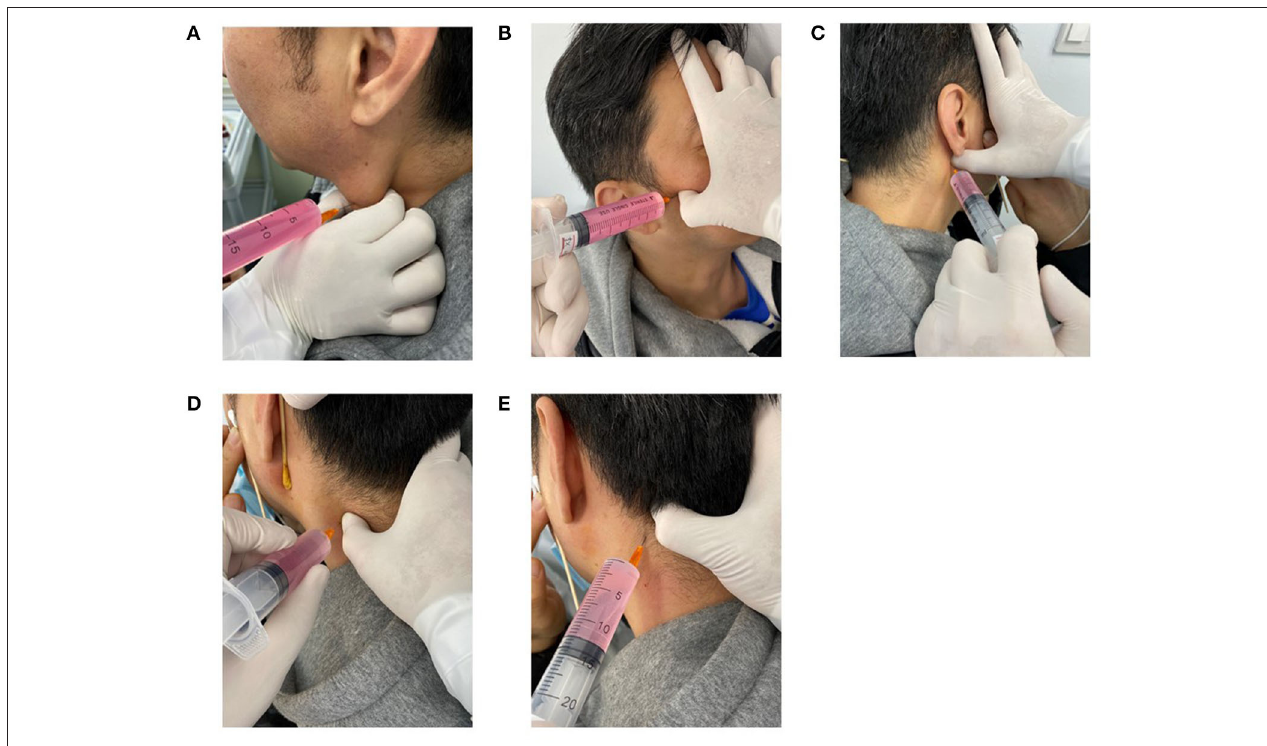
FIGURE 1 | Performance of the latent MTrPs injection for AR. Sternocleidomastoid muscles latent MTrPs injection (A) . Lateral pterygoid muscles latent MTrPs injection (B) . Medial pterygoid muscles latent MTrPs injection (C) . Splenius capitis and Semispinalis muscles latent MTrPs injection (D, E) . MTrPs, myofascial trigger points.